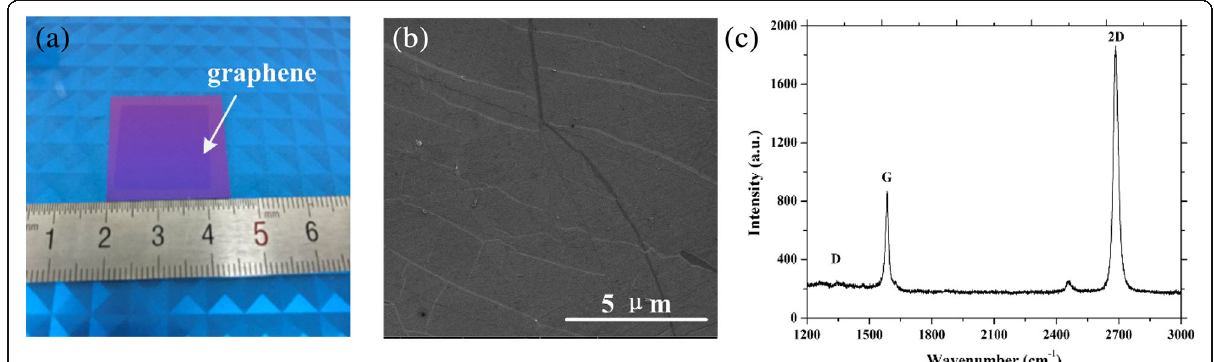
Fig. 2 Optical photograph of a 2 × 2 cm 2 graphene on SiO 2 /Si substrate ( a ). SEM image of the transferred graphene ( b ). Typical Raman spectrum showing the basic features of graphene ( c